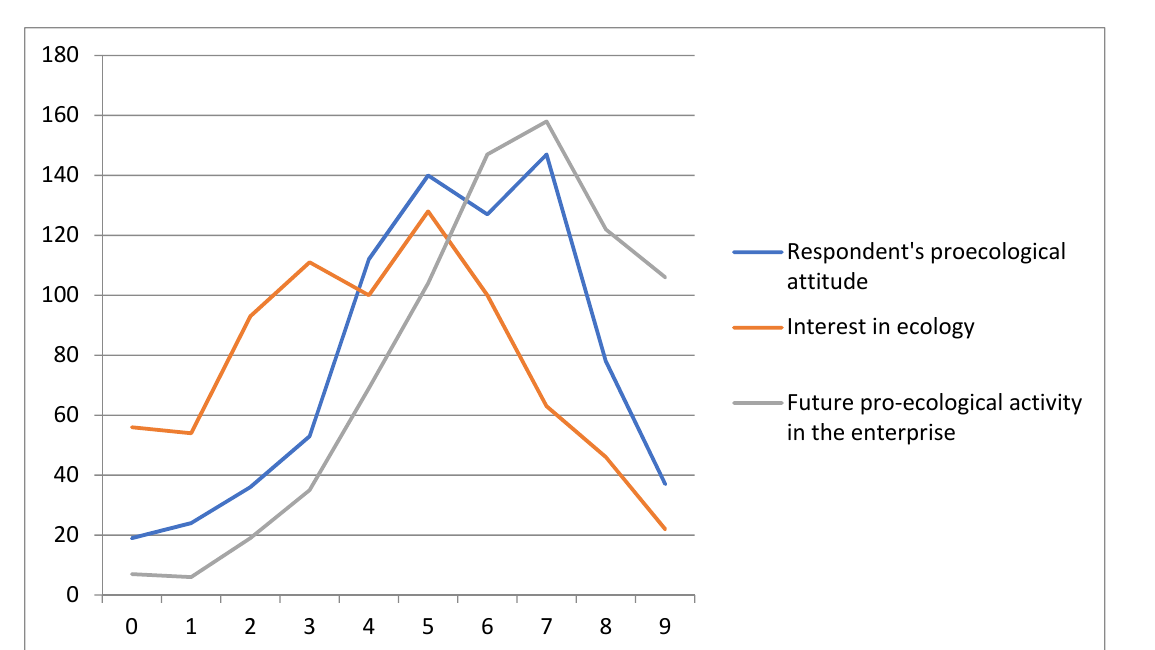
Figure 1. The structure of the pro-ecological orientation of the younger generation. Source: own study (based on Table 1).